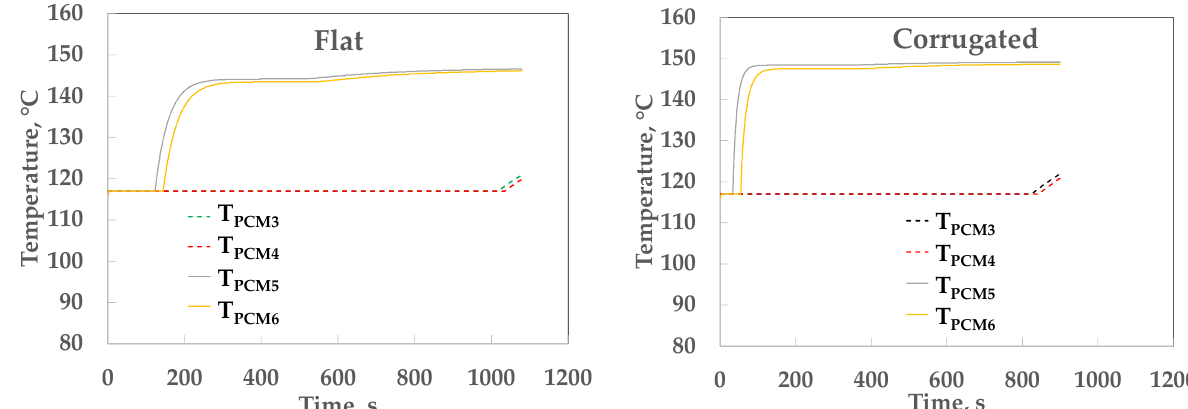
Figure 8. Temperature profiles in the side and center of the PCM.